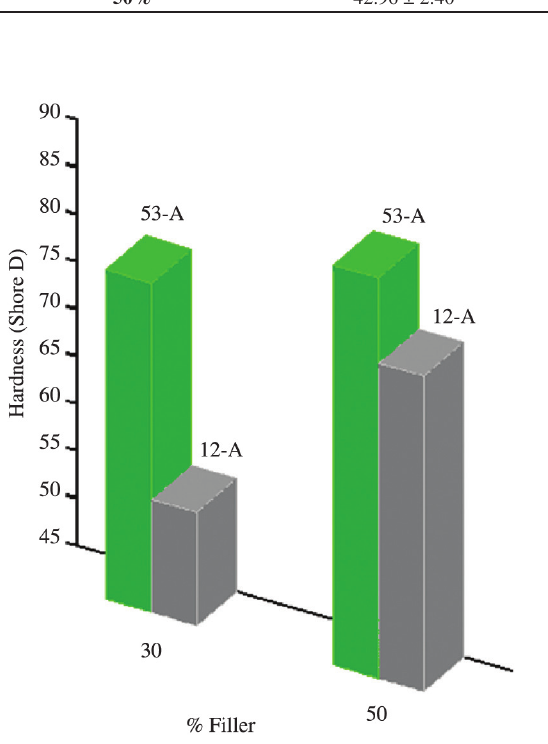
Figure 7. Variation of hardness with